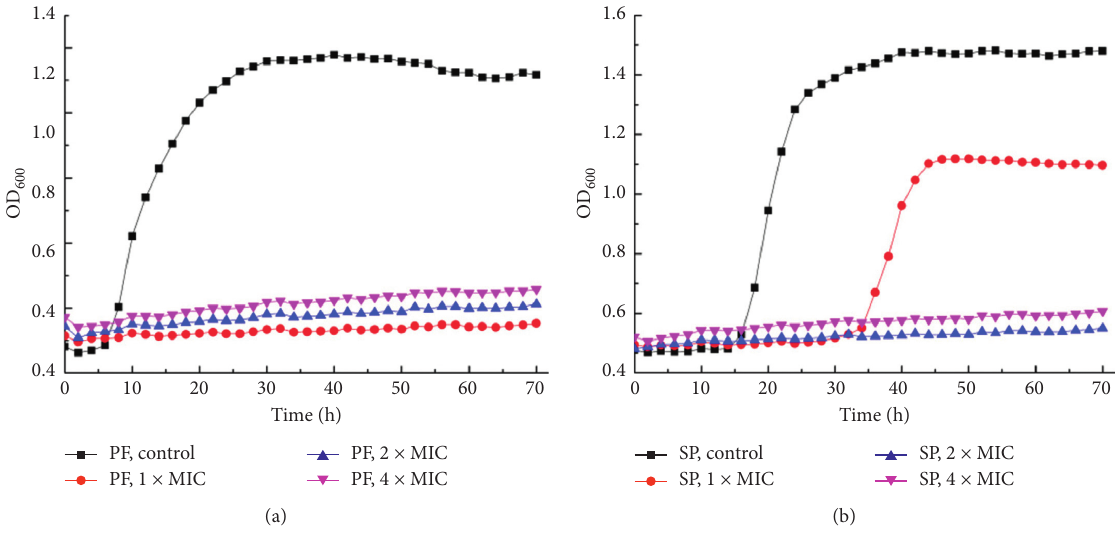
Figure 2: Growth curve of daphnetin against P. fluorescens (a) and S. putrefaciens